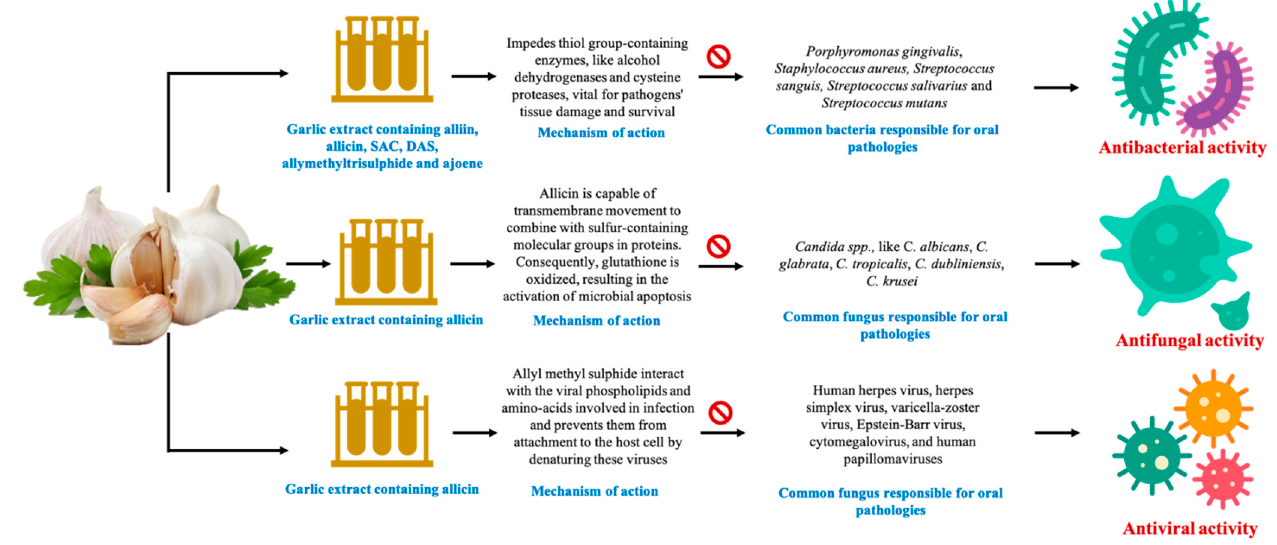
Figure 4. Antimicrobial and antiviral activities of garlic extract against oral pathogens.